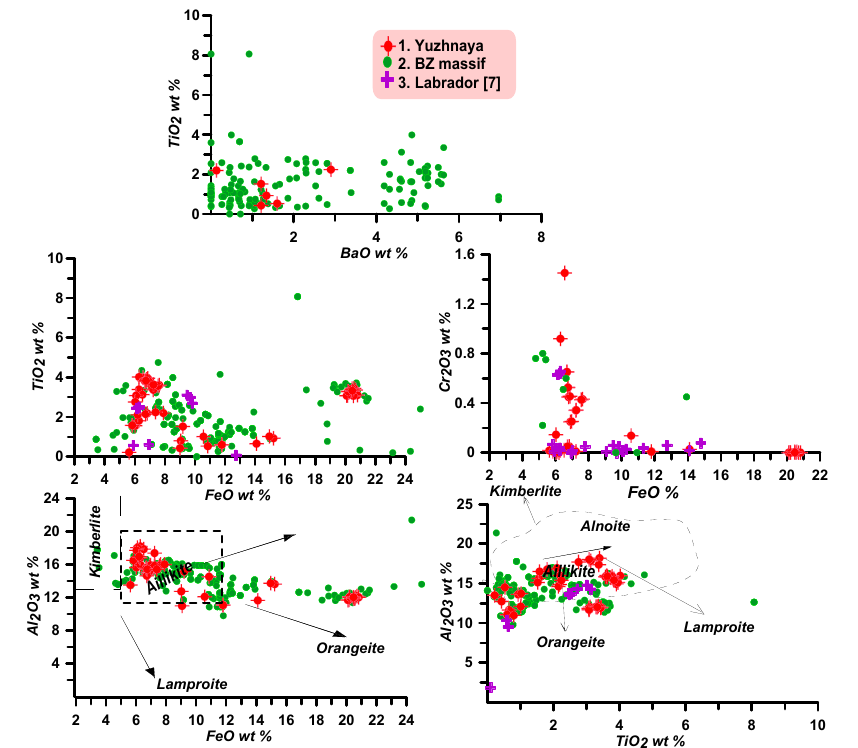
Figure 15. Variations of phlogopite compositions from BZM. The fields and arrows after [66].